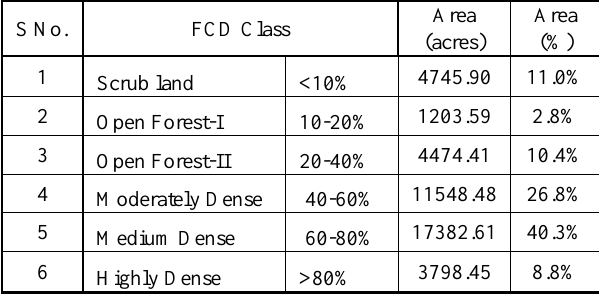
Figure 5. Show the spatial locations of areas with low forest density (FCD < 40%) within the forest boundary. These are